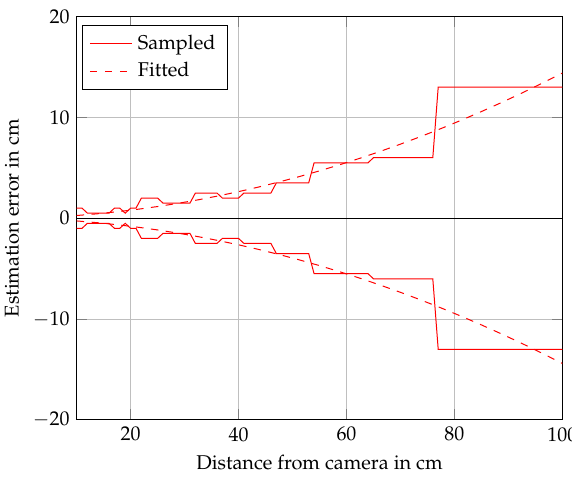
Figure 9. Corresponding error plot of the depth estimation depending on the object